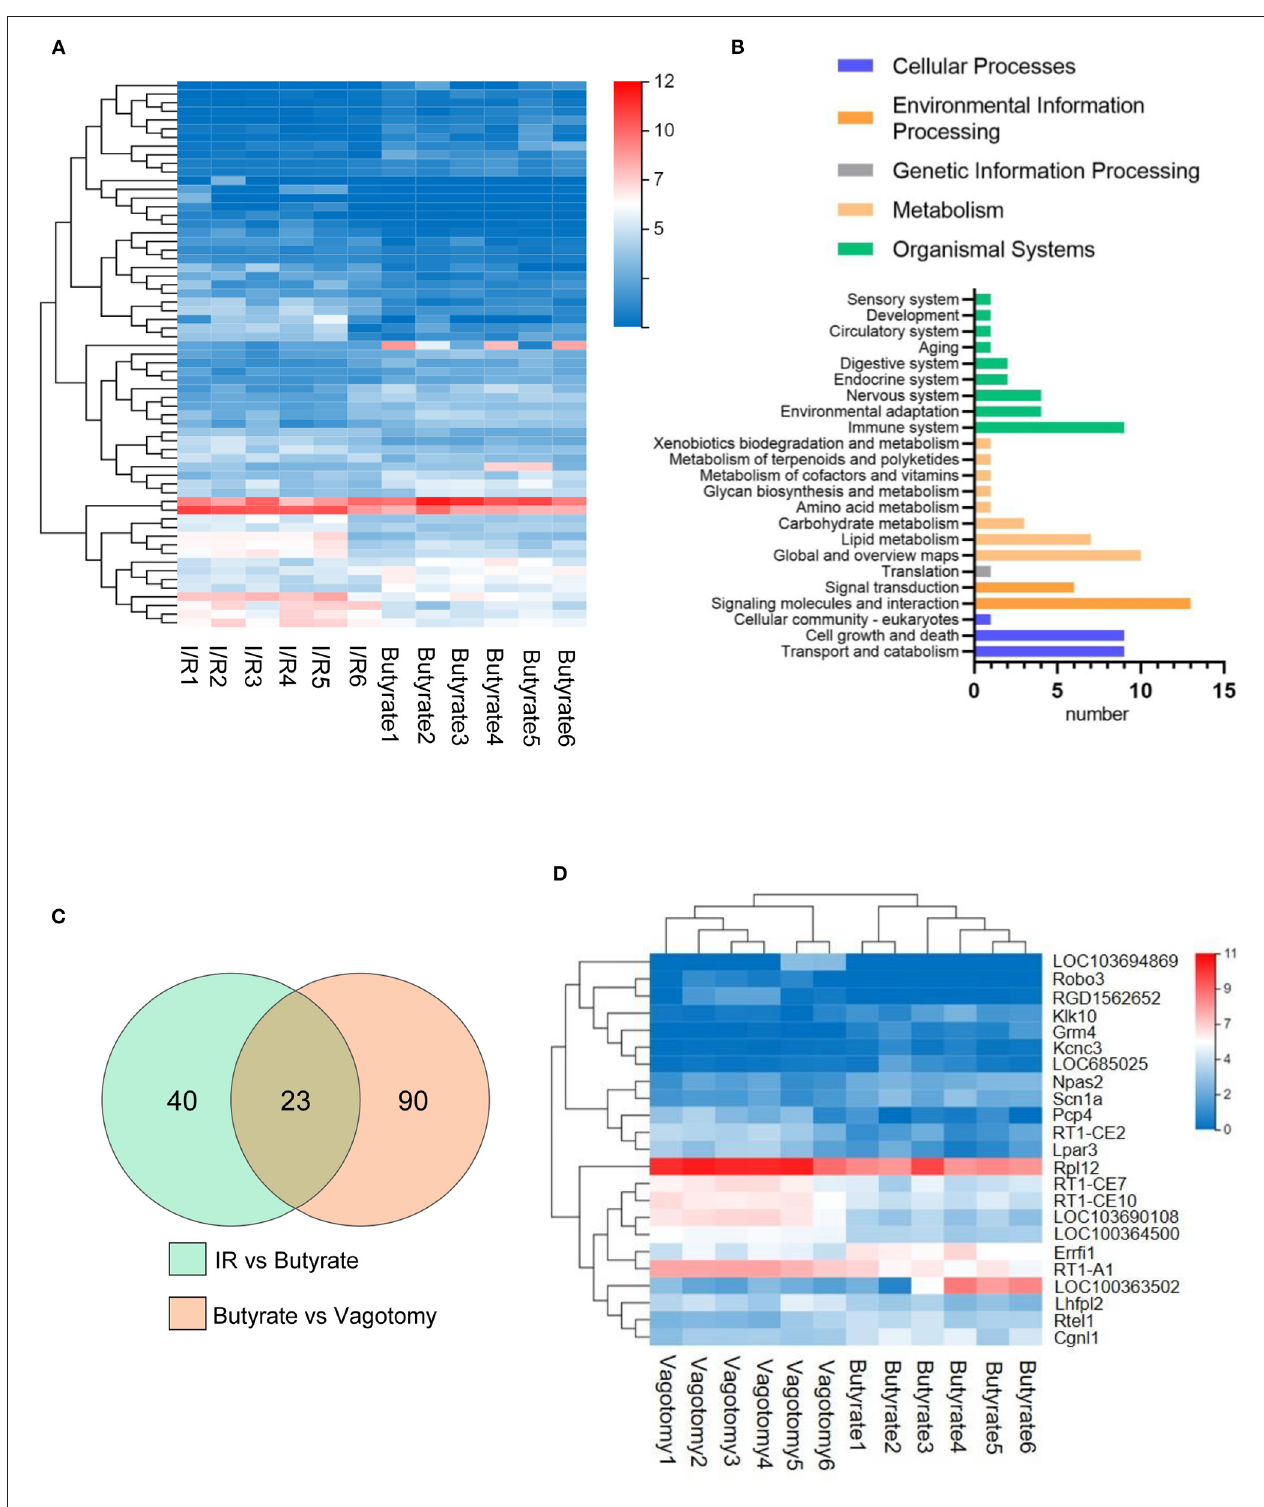
FIGURE 4 | Butyrate induced protective modulation of the transcriptional expression profiles obtained by I/R, and this protective effect was reversed by vagotomy. (A) Heat map showing up-regulated or down-regulated DEGs in myocardium induced by butyrate; (B) KEGG pathway classification of DEGs changed by butyrate. (C) Venn map of DGEs among I/R, butyrate, and vagotomy group. (D) Heat map showing expression of butyrate altered genes reversed by vagotomy. DEGs, differentially expressed genes.